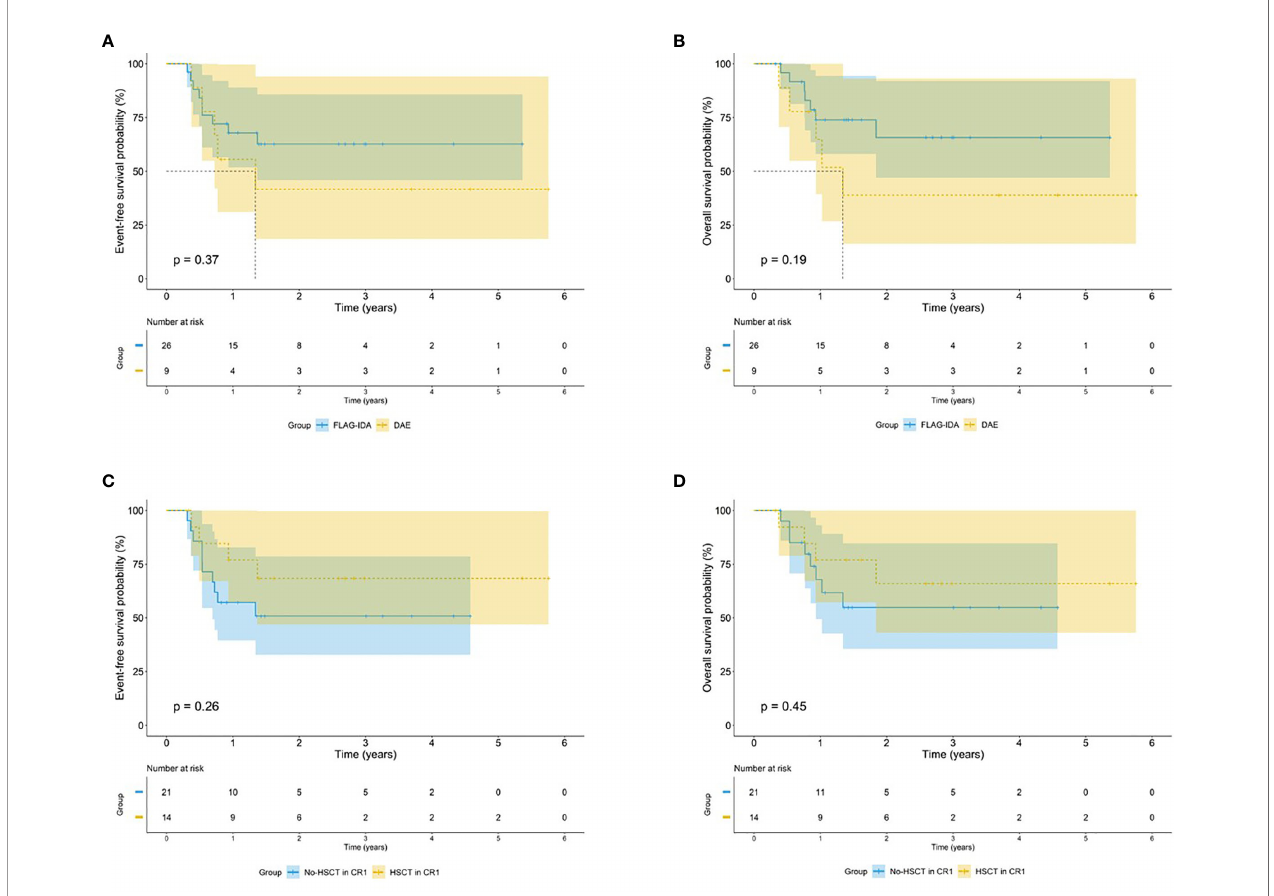
FIGURE 5 | Survival outcomes by treatment regimens among EVI1 high patients. Kaplan – Meier curve estimates the impact of different induction regimens on the (A) EFS and (B) OS in the cohort of EVI1 high patients. Kaplan – Meier curve estimates the impact of HSCT after CR1 on the (C) EFS and (D) OS in the cohort of EVI1 high